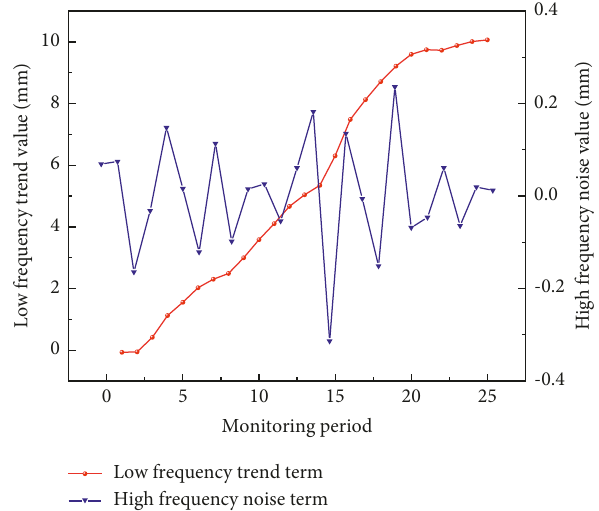
Figure 1: Schematic diagram of the low-frequency trend item and the high-frequency noise